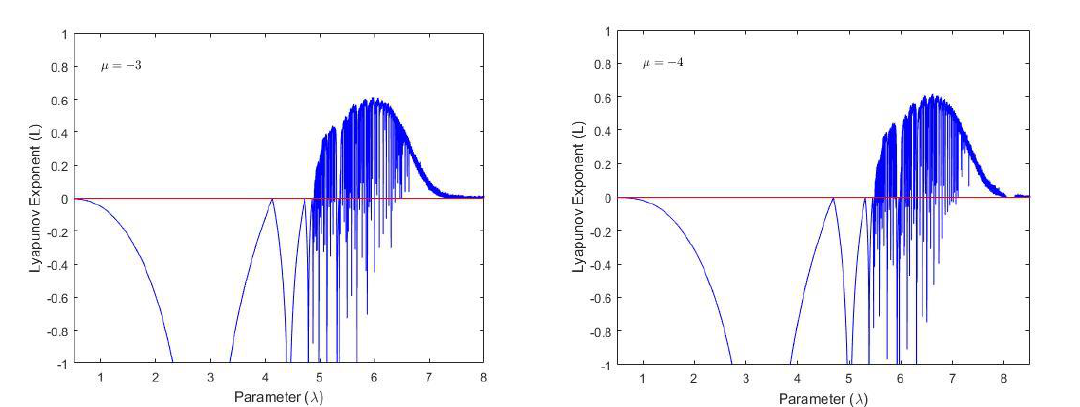
Figure 14. Lyapunov exponents for μ = − 3 Figure 15. Lyapunov exponents for μ = −